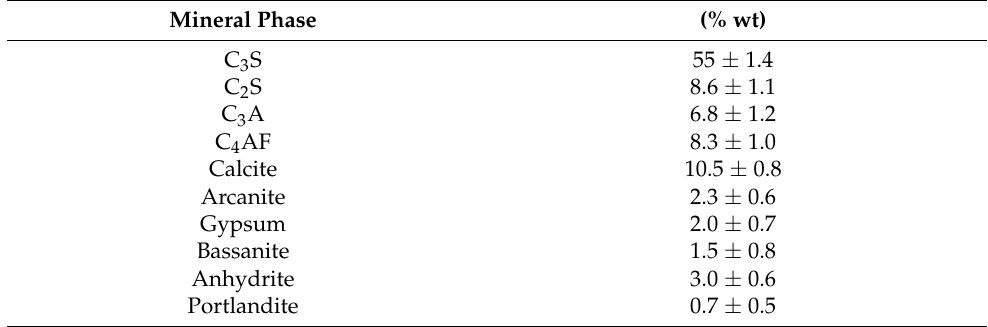
Table 3. Mineralogical composition of the CEM II/A-LL42,5R by X-Ray Diffraction and